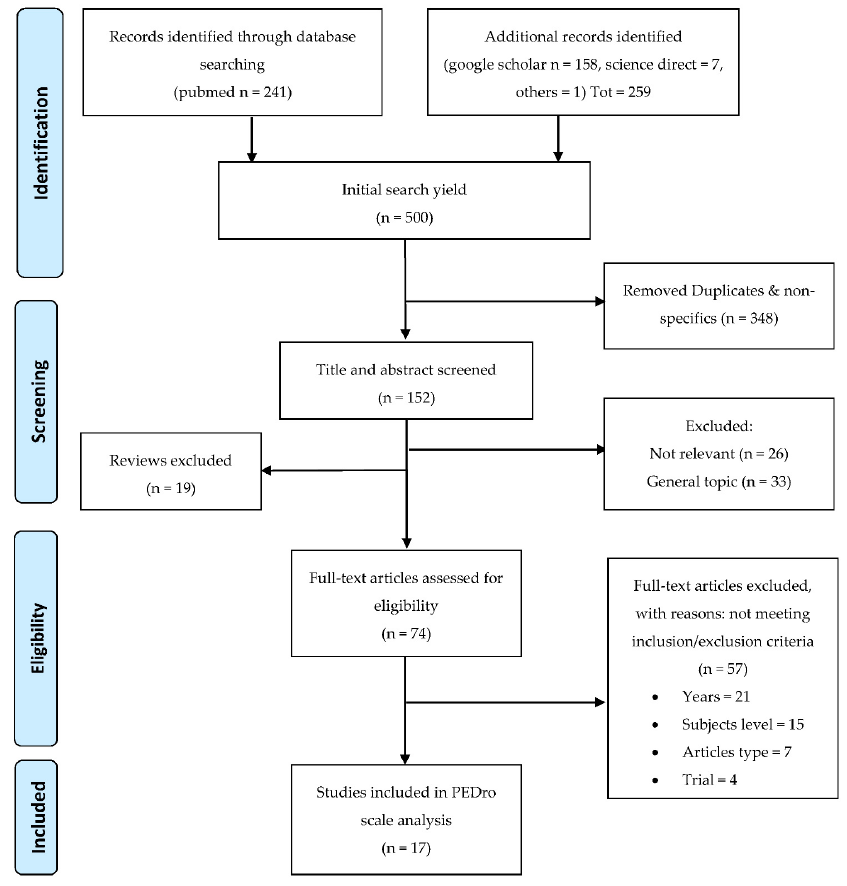
Figure 1. PRISMA flow diagram. The selection process and the inclusion and exclusion criteria used in the systematic review.